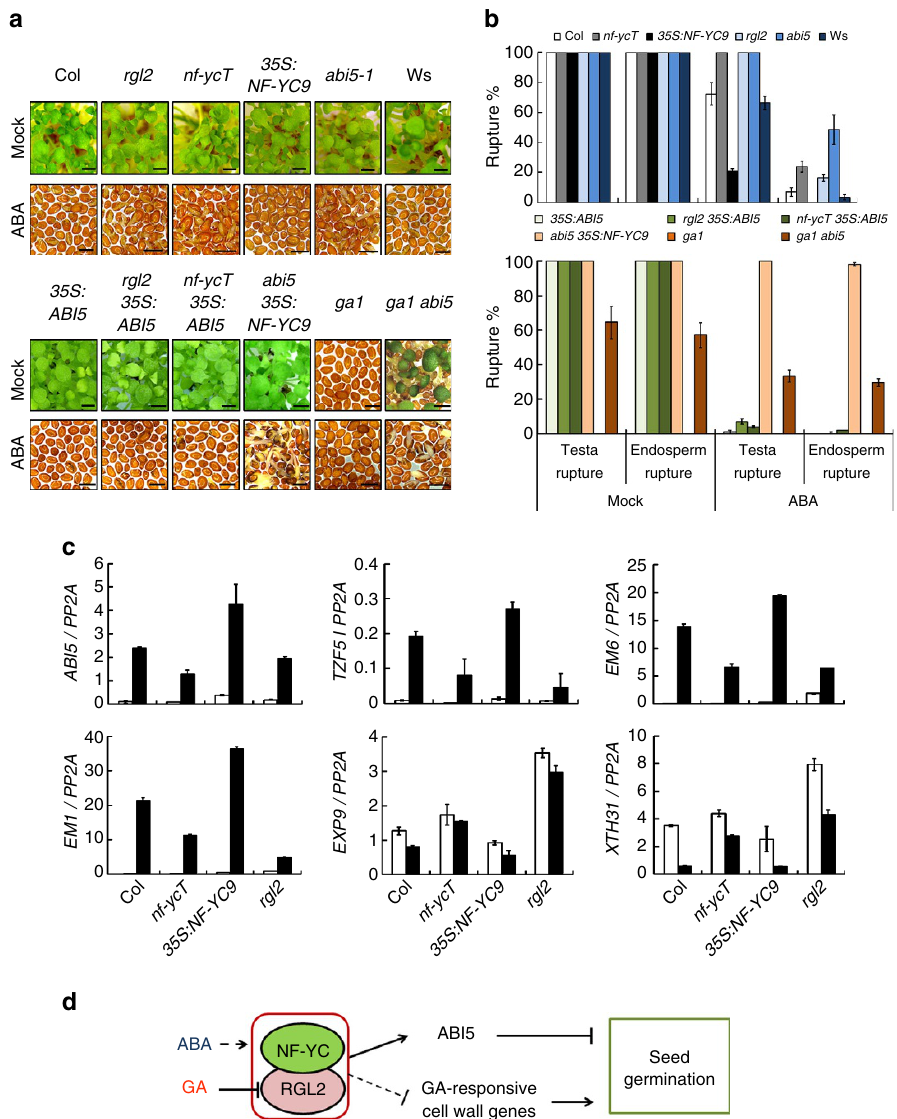
Figure 7 | NF-YCs and RGL2 are involved in the ABA-mediated inhibition of germination. ( a ) Germination phenotypes of rgl2 , nf-ycT , abi5 , 35S:NF-YC9 , 35S:ABI5 , the wild-type (Col and Ws) seeds and their combinatorial lines observed at 120 HAS on 1/2 MS medium containing 2 m M ABA or not (mock). Scale bar, 1mm ( b ) Statistic analysis of the testa and endosperm rupture rate in germinating seeds described in a . Data represent mean ± s.d. of at least 100 seeds. ( c ) Quantitative RT–PCR analysis of several representative genes expression in nf-ycT , 35S:NF-YC9 , rgl2 and the wild-type seeds grown on 1/2 MS medium containing 2 m M ABA or not for 12 HAS. Data represent mean ± s.d. of three replicates. ( d ) A model of NF-YC-RGL2-mediated seed germination by integrating GA and ABA signalling. Solid lines indicate the direct or definite regulation; dotted lines indicate the indirect or undetermined